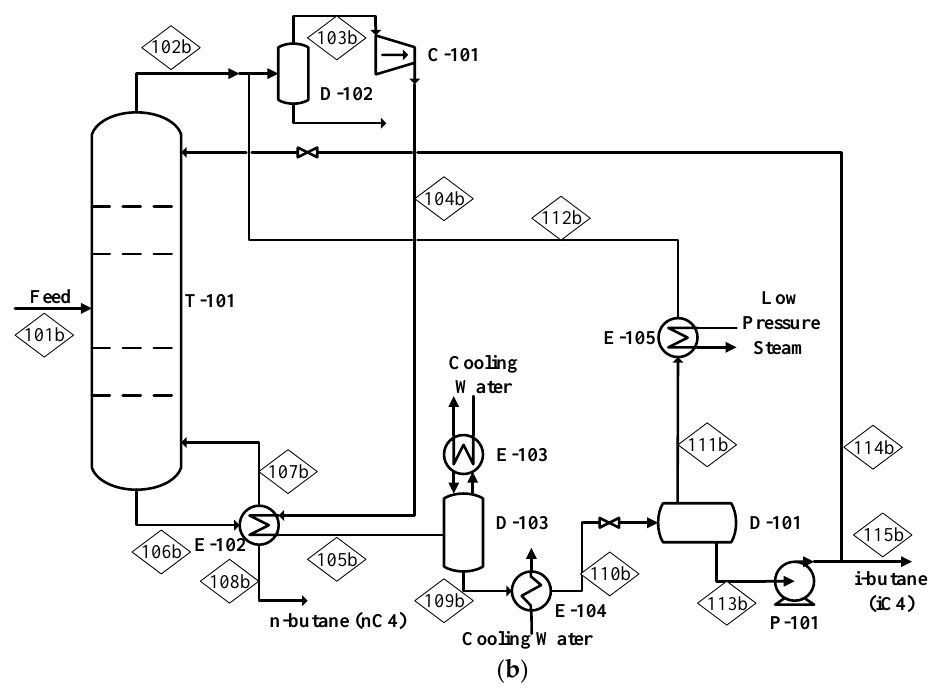
Figure 1. Process flow diagram for the C4 splitter in ( a ) conventional and ( b ) heat pump-assisted distillation.